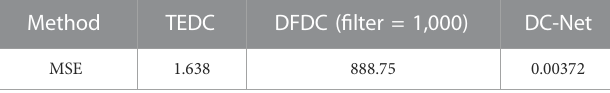
TABLE 2MSEof errors betweenthe continuationgravityanomalyresults andthe true gravity anomaly using different methods at 0 m altitude.